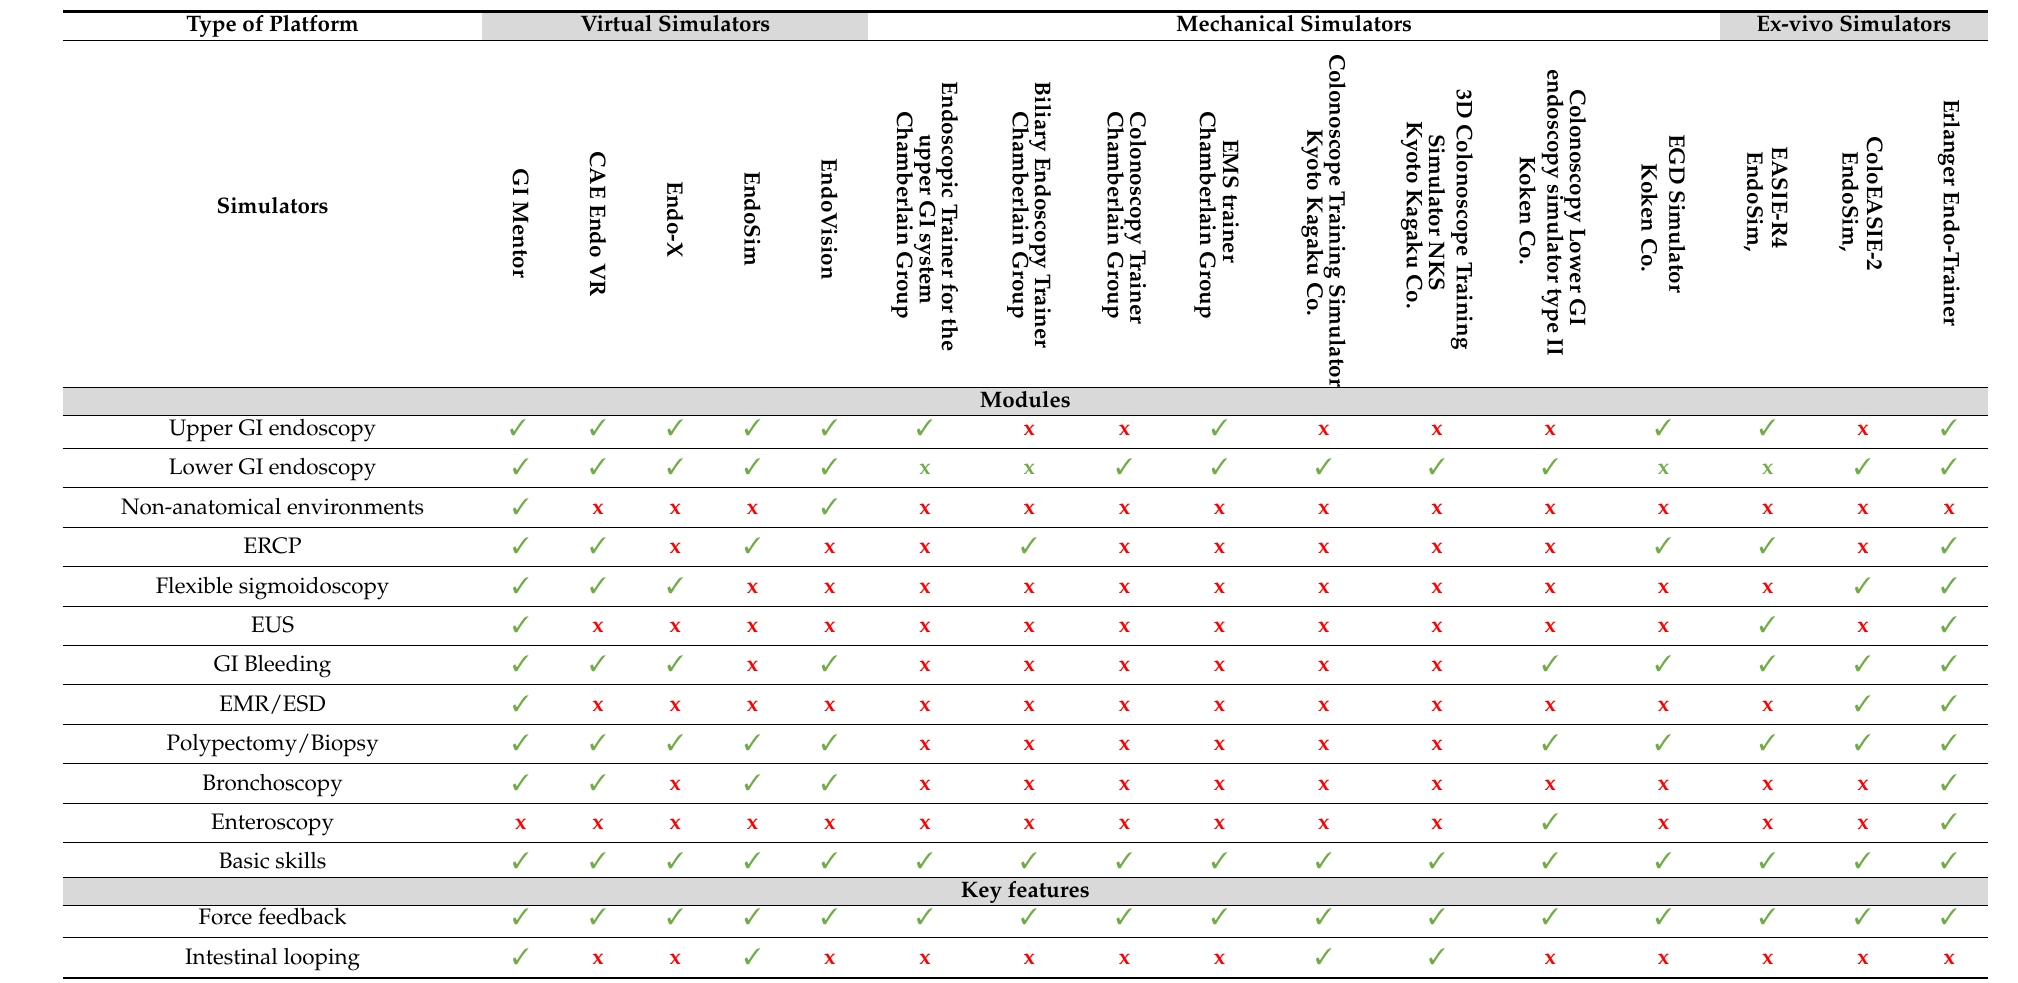
Table 2. Comparison of modules and key-features of the different GI